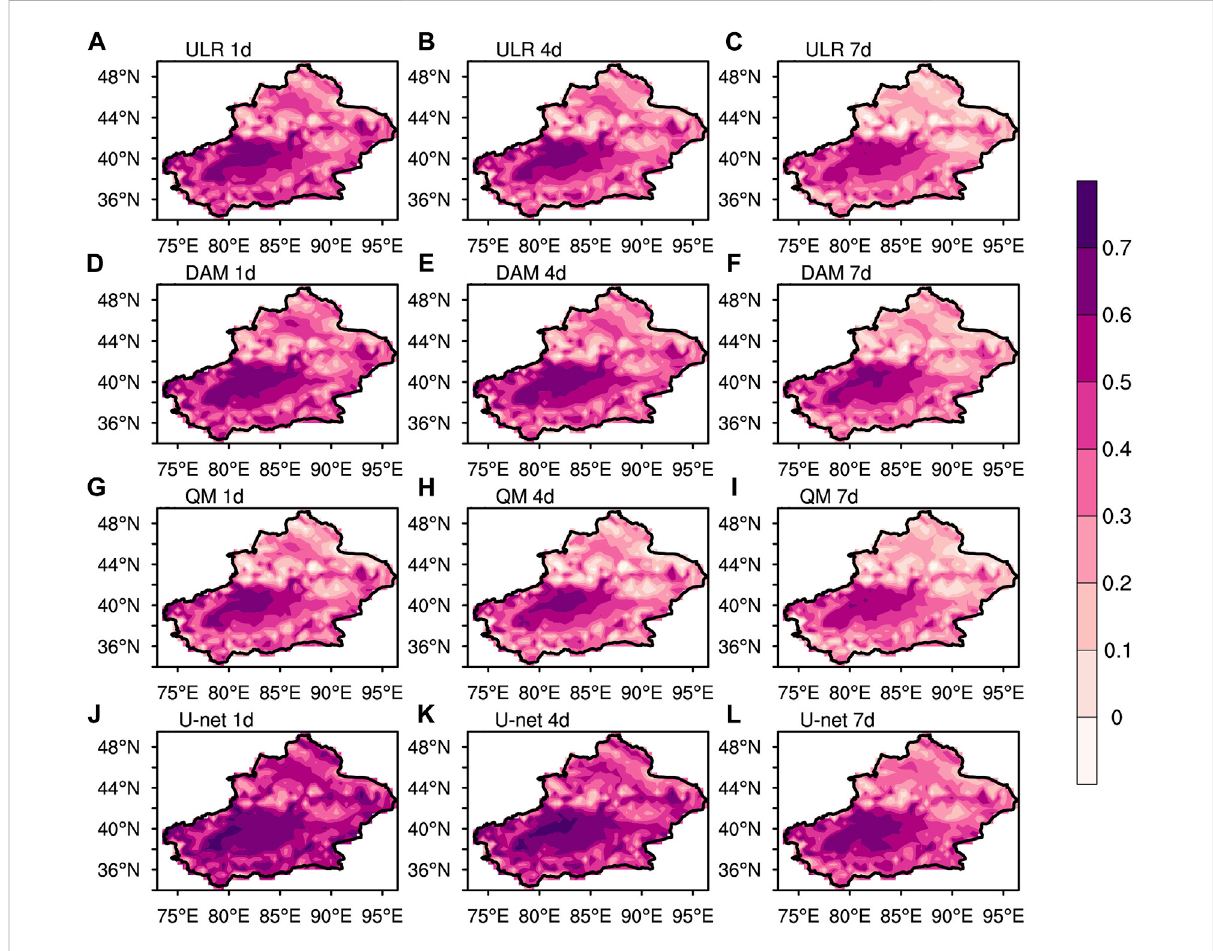
FIGURE 5 Spatial distributions of the MAESS of ULR (A – C) , the DAM (D – F) , QM (G – I) and U-net (J – L) to the raw GEFS forecast with lead times of 1, 4, and 7